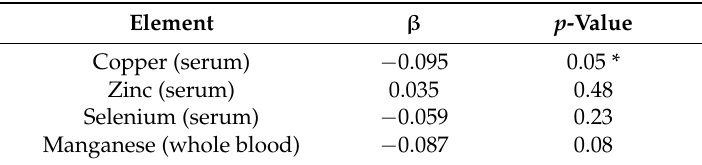
Table 4. Spearman’s rank correlation coefficient ( p -value) of association between maternal serum Al and essential elements (Cu, Zn, and Se in serum and Mn in blood) at delivery ( n = 416). Element β